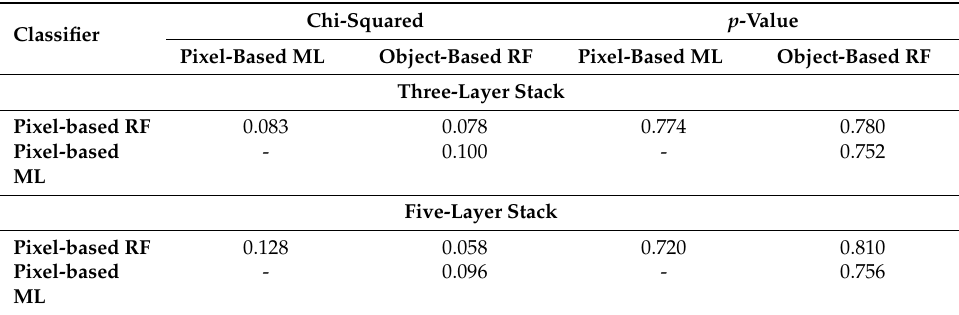
Table 3. McNemar’s chi-squared test summary of the classification accuracy differences observed by the three classifiers. No significant differences were found between the three classification methods we employed when using either a three- or five-layer